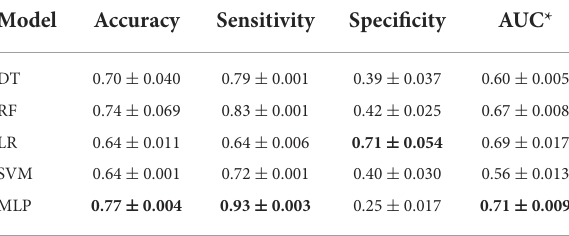
TABLE 4 ML model results for the three test subsets.